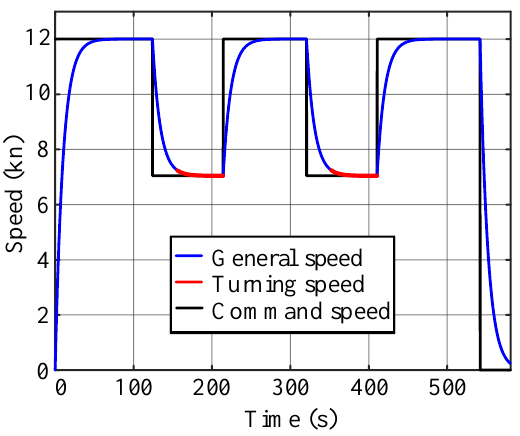
Figure 13. Speed curve of the large-angle turning tracking